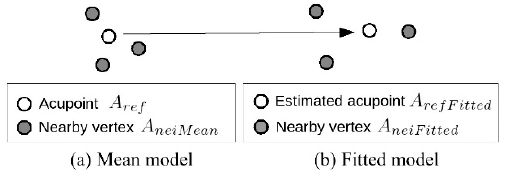
Figure 4. Visualized acupoint during the estimation process. ( a ) Mean model, ( b ) Fitted model.